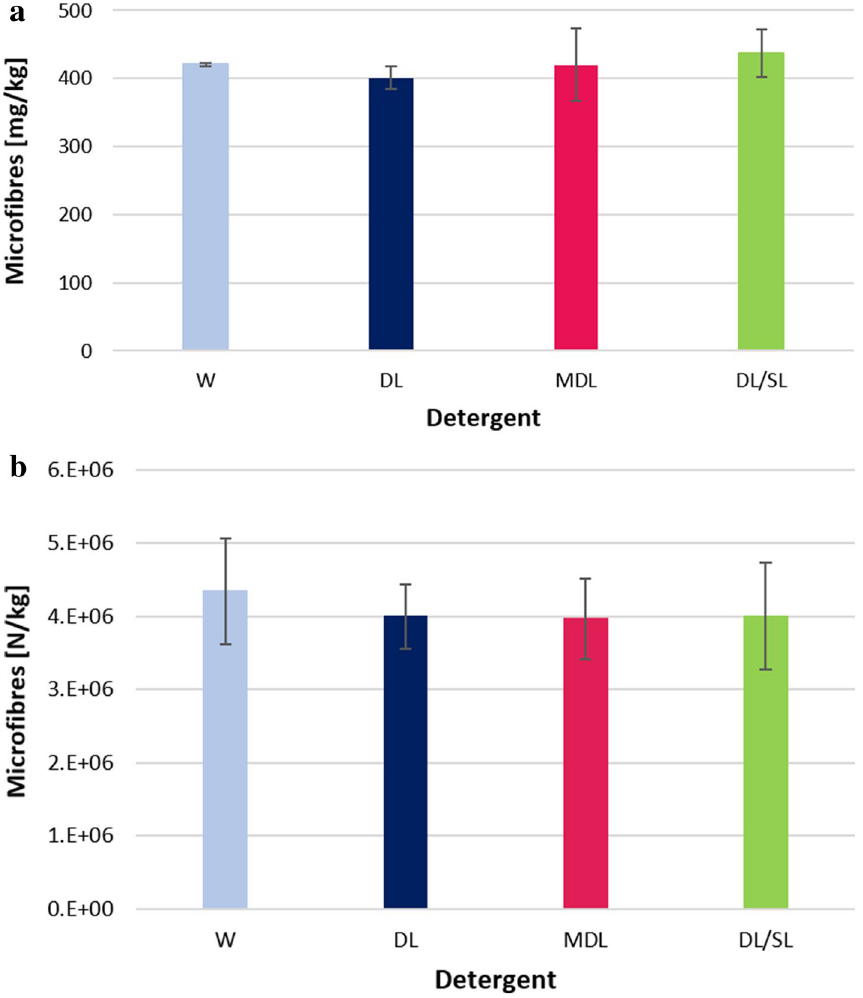
Figure 3. ( a ) Microfibres released per kg of washed fabric (expressed in mean mg/kg ± SD, n = 3) during washing processes performed with water (W), commercial liquid detergent (DL), mild liquid detergent (MDL) and combination of the commercial liquid detergent and commercial softener (DL/SL). ( b ) Number of microfibres released per kg of washed fabric (expressed in mean N/kg ± SD, n = 3) during washing processes performed with W, DL, MDL and